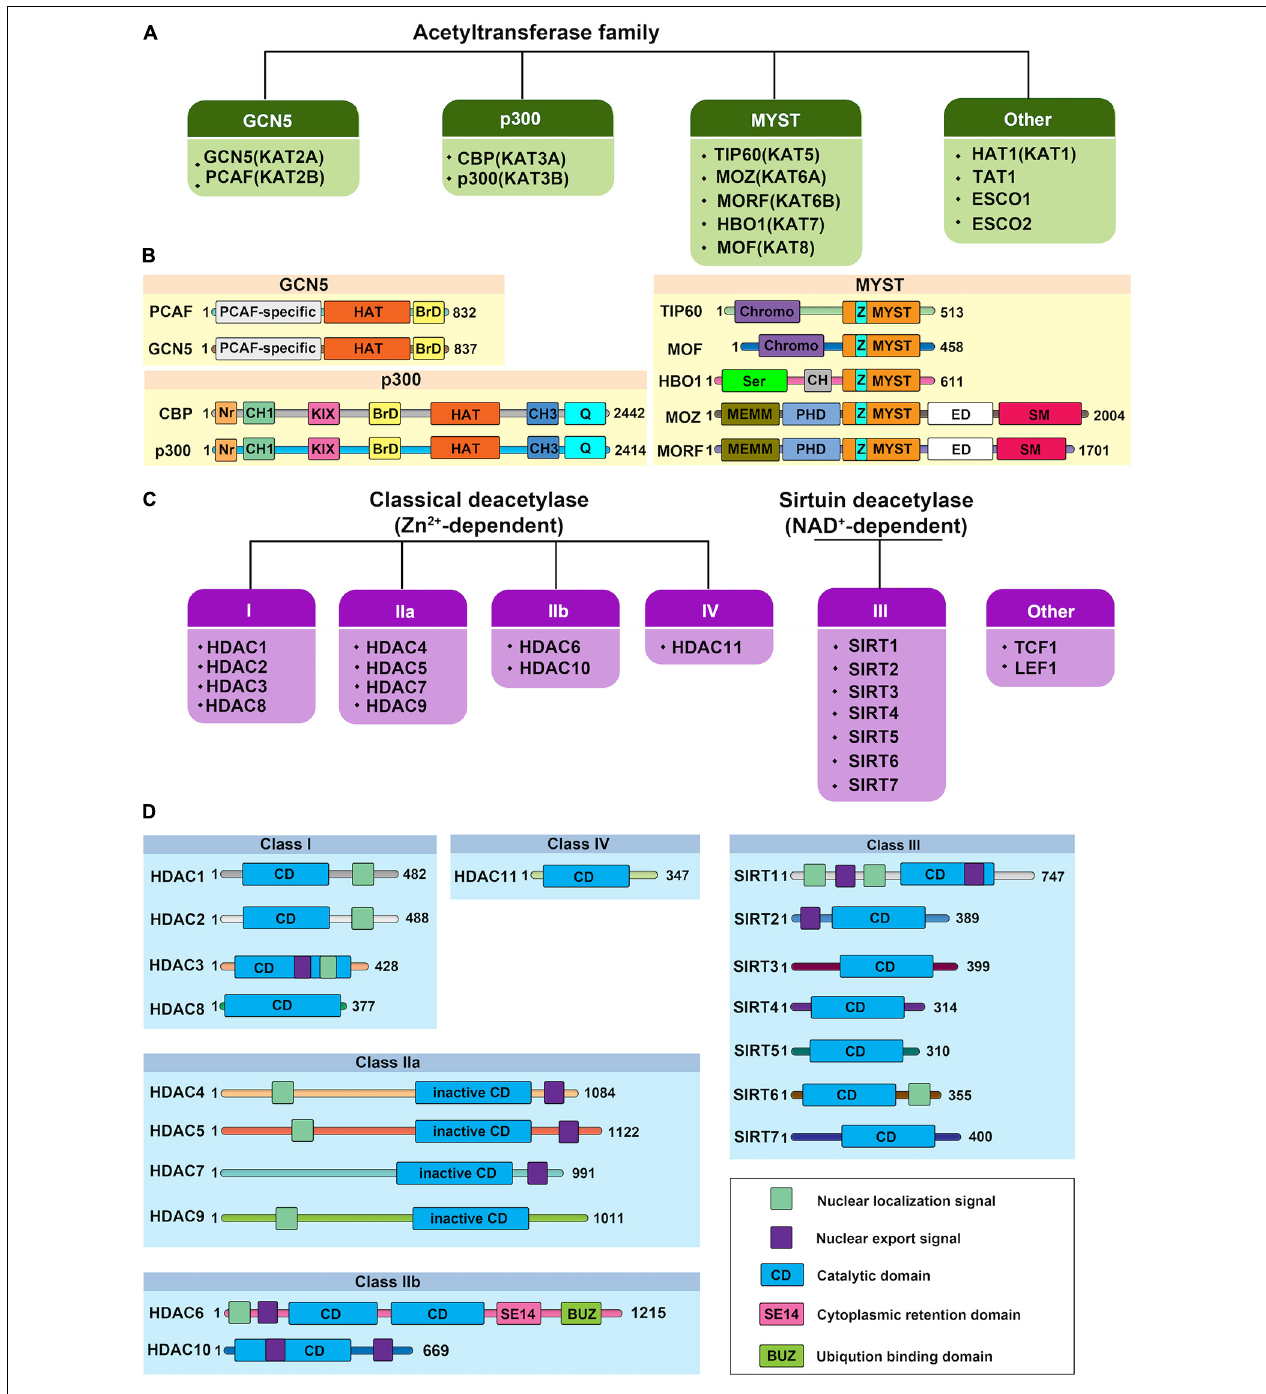
FIGURE 2 | Protein structure of human histone acetylases and deacetylases. (A) The canonical histone acetyltransferases (HATs) are classified into three prominent families: GCN5, p300, and MYST. The other HATs are relatives dissimilar to each other. (B) Protein structure of human histone acetyltransferases. BrD, bromodomain; Nr, nuclear receptor-interacting box; CH, cysteine/histidine-rich module; KIX, phospho-CREB interacting module; Q, glutamine-rich domain; HAT, the lysine acetyltransferase catalytic domain; Chromo, chromodomain; Ser, serine-rich domain; NEMM, N-terminal part of MOZ or MORF; PHD, PHD zinc finger; ED, glutamate/aspartate-rich region; SM, serine/methionine-rich domain; MYST, MYST histone acetyltransferase domain; Z: C2HC zinc finger domain within the MYST domain. Numbers indicate the length of each protein. (C) Histone deacetylases (HDACs) are divided into two categories: the classical Zn 2 + -dependent HDACs and NAD + -dependent sirtuin deacetylases. Based on their phylogenetic conservation and sequence similarities, the HDACs are further classified into five major families: Class I, Class IIa, Class IIb, Class III, and Class IV. (D) Protein structure of human histone deacetylases. Protein domains of HDAC isoenzymes are presented above. Most HDACs possess a nuclear localization and/or export signal. Numbers indicate the length of each protein.